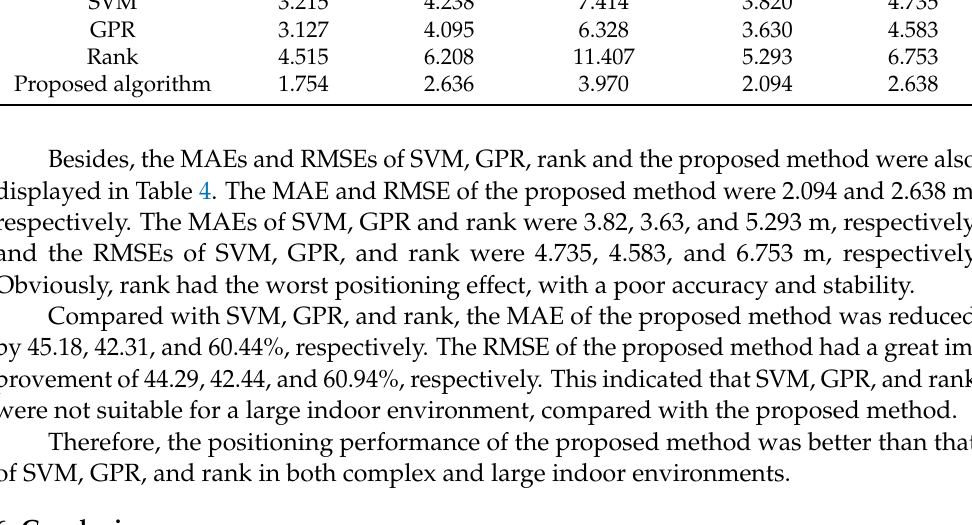
Table 4. Statistical results of positioning errors of SVM, GPR, rank and the proposed method (m).